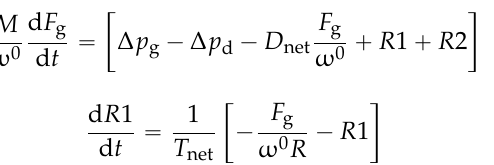
Figure 6. “Power system” block ( T sc (s) is the parameter of the transfer function used to model the secondary load frequency control of the synchronized thermal units).